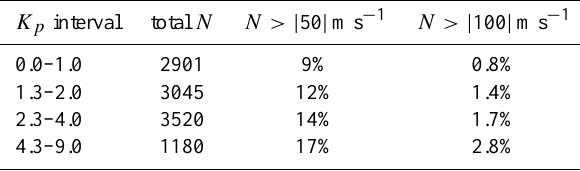
Table 3. Davis vertical winds selected by K p